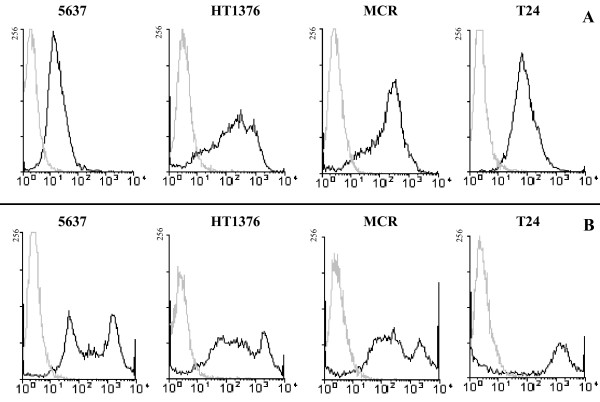
Bladder cancer cell lines express both T and sialyl-T antigens. The bladder cancer cell lines, 5637, HT1376, MCR and T24, treated with heat-inactivated neuraminidase (A) or with active neuraminidase (B) were analyzed by Flow cytometry using fluorescent PNA lectin. The gray line shows the controls without PNA. The T antigen is expressed at high levels by the HT1376 and MCR cell lines, but only weakly by 5637 cells and at an intermediate level by T24. According to the results obtained after removing the cell surface sialic acid by neuraminidase treatment, the 5637 and T24 cell lines express the T antigen masked by sialic acid.